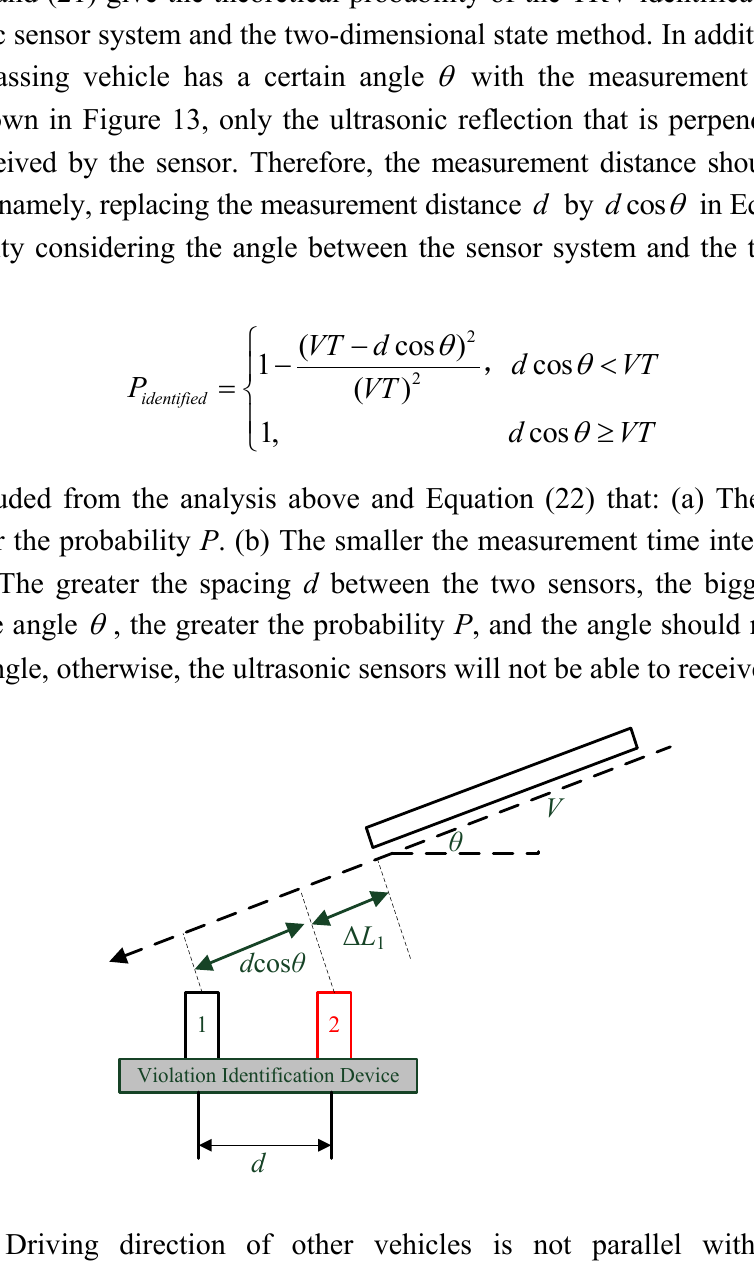
Figure 13. Driving direction of other vehicles is not parallel with the violation identification